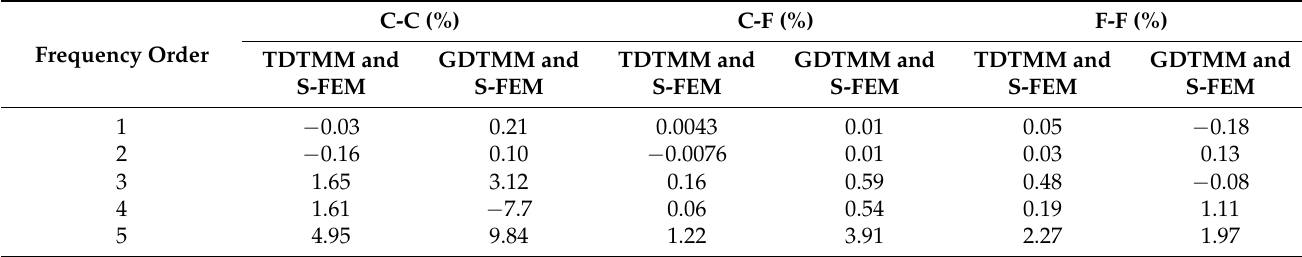
Table 7. The error of natural frequencies between TMM (TDTMM and GDTMM) and S-FEM analyses in example